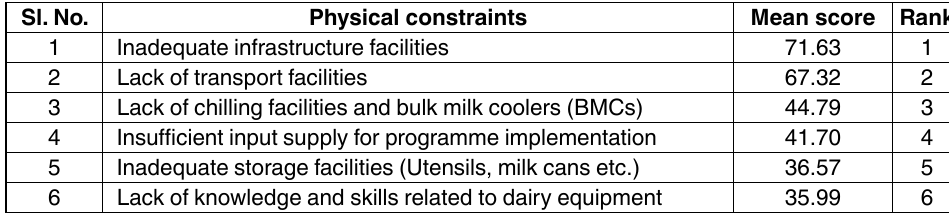
table 1. Physical constraints as perceived by the FEFs of DDD, Kerala sl.